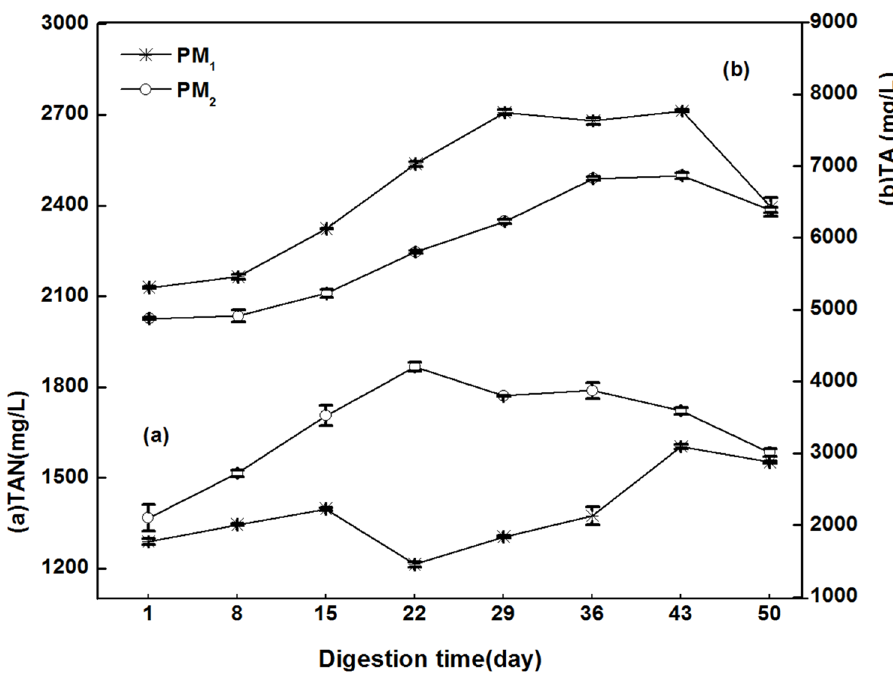
Fig 6. The dynamic changes of TAN (a) and TA (b) of PM 1 and PM 2